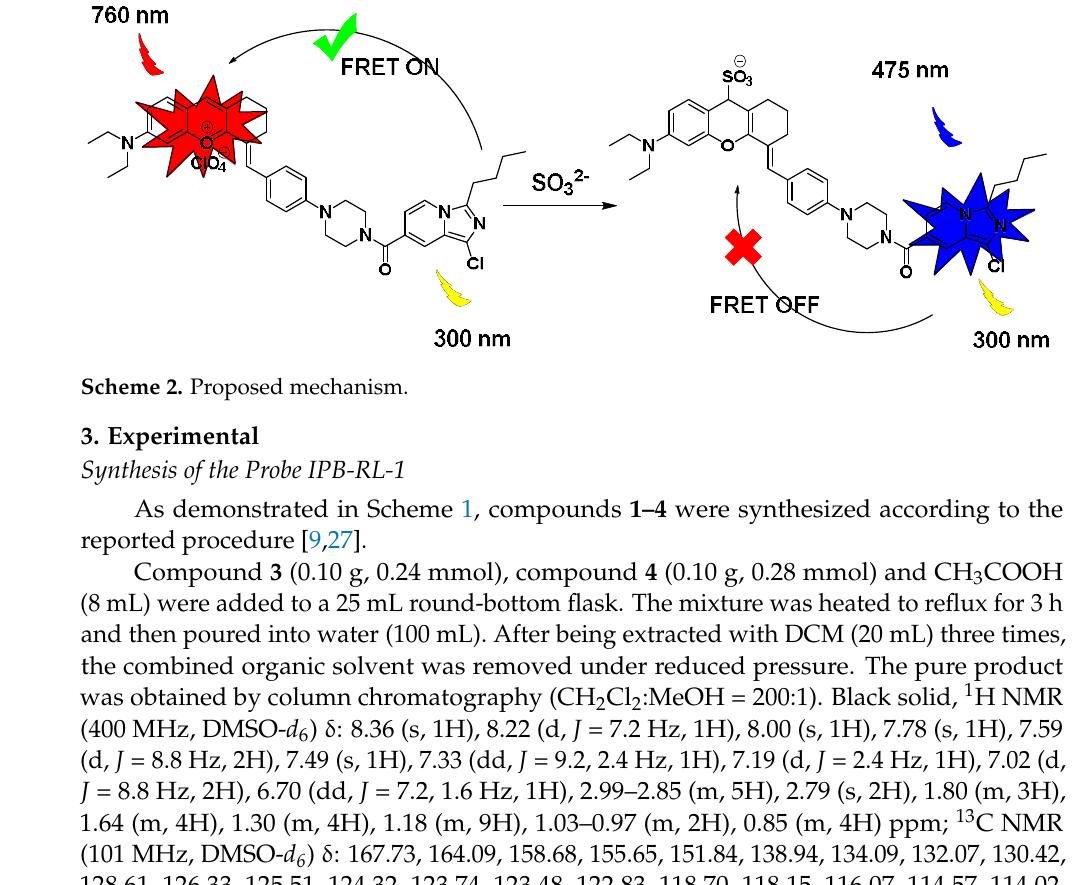
6 of 9 Figure 6. Fluorescence images of IPB-RL-1 in living mice. ( a ) Images of the mice only; ( b ) images after 100 μL of 50 μM IPB-RL-1 was injected into the mice for 5 min; ( c ) images after 100 μL of 25 μM SO 32− was injected into the mice for 5 min; ( d ) images after re-injection of 100 μL 50 μM SO 32- at the same location for 5 min (λ ex = 635 nm, λ em = 698 − 766 nm). Based on the above results, we envisioned the mechanism of detection as follows (Scheme 2). At the excitation wavelength of 380 nm, the donor